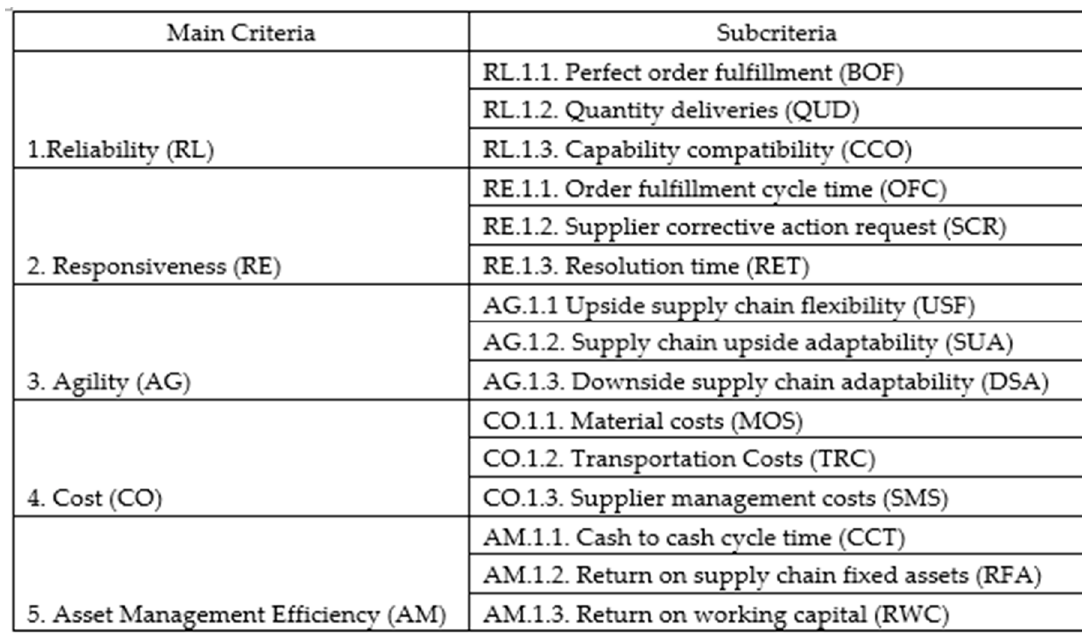
Figure 5. The FANP structure.